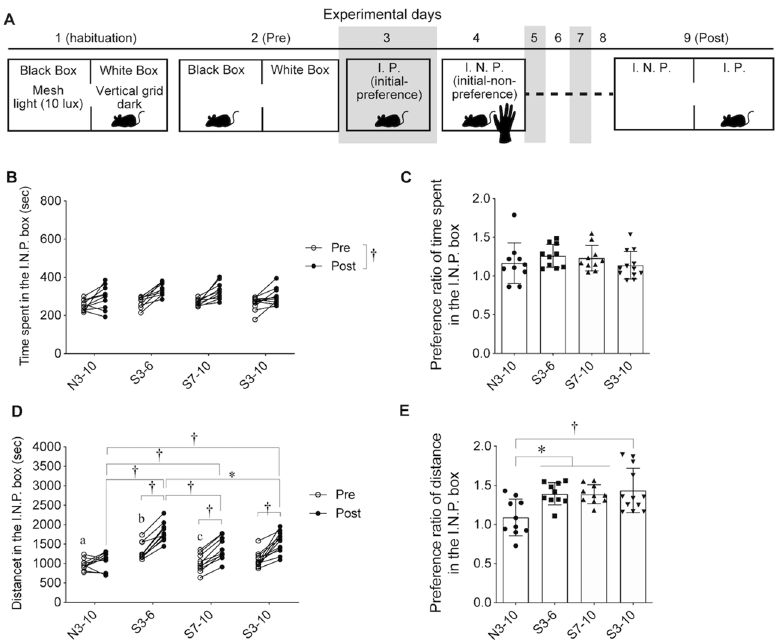
Figure 5. Results of the conditional place preference test. ( A ) Time course of experimental procedures for the conditioned place preference test. ( B ) Times spent staying in an initial non-preference (I.N.P.) box before (pre) and after (post) conditioning. Time spent staying in an I.N.P. box where rats received stroking stimuli was significantly longer after conditioning than that before conditioning. ( C ) Preference ratio of time spent in the I.N.P. box. The preference ratio of time [(time spent staying in the I.N.P. box during the post-conditioning)/ (time spent staying in the I.N.P. box during the pre-conditioning)] was not significantly different among the groups. ( D ) Distances of locomotion in the I.N.P. box were significantly increased compared to those before receiving conditioning in the S3-6, S7-10, and S3-10 groups. Distances of locomotion after conditioning in the S3-6, S7-10, and S3-10 groups were significantly larger than the distance in the N3-10 group. Distance of locomotion after conditioning in the S3-6 group was significantly larger than the distances in the S7-10 and S3-10 groups. Distance of locomotion before conditioning in the S3-6 group was significantly larger than the distances in the N3-10 and S7-10 groups. ( E ) Preference ratios of locomotion distance. Preference ratios of locomotion calculated as [(locomotion distance in the I.N.P. box during the post-conditioning)/(locomotion distance in the I.N.P. box during the pre-conditioning)] were significantly higher in the S3-6, S7-10, and S3-10 groups than in the N3-10 group. †, P < 0.01; *, P < 0.05; a vs. b, P < 0.01; a vs. c, P < 0.05. Repeated measures two- way ANOVA (group × timing) followed by post-hoc Holm’s